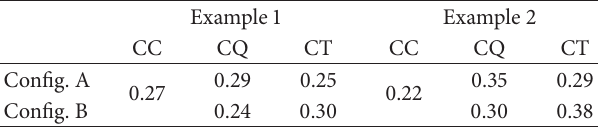
Table 1: Ideal reconstruction